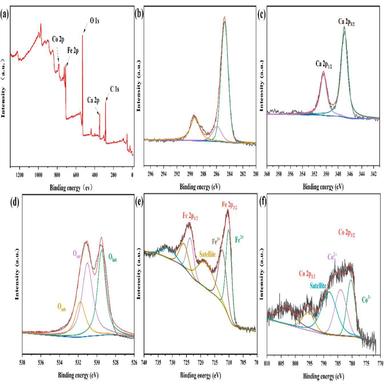
The XPS spectra of CoFe@Eggshell: survey spectra (a), C 1 s (b), Ca 2p (c), O1s (d), Fe 2p (e), Co 2p (f).